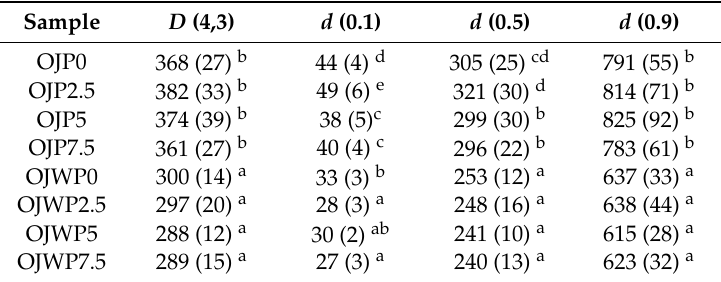
Figure 3. ( a ) Volume particle size distributions (representative curves) of pasteurised orange juice with pulp; ( b ) Volume particle size distributions (representative curves) of pasteurised orange juice without pulp. OJP, orange juice with pulp; OJWP, orange juice without pulp. Table 2. Mean values (and standard deviations) of volume mean diameter ( µ m) D (4,3), standard percentiles ( µ m) d (0.1), d (0.5), and d (0.9) of pasteurised orange juice.